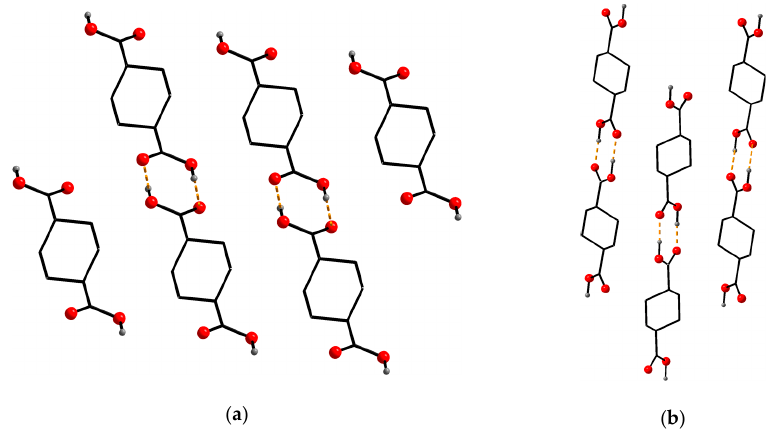
Figure A1. Packing of H 2 chdc molecules in 6 (CCDC 1973668) ( a ) and the previously reported H 2 chdc ( b ). Hydrogen bonds are shown in orange.